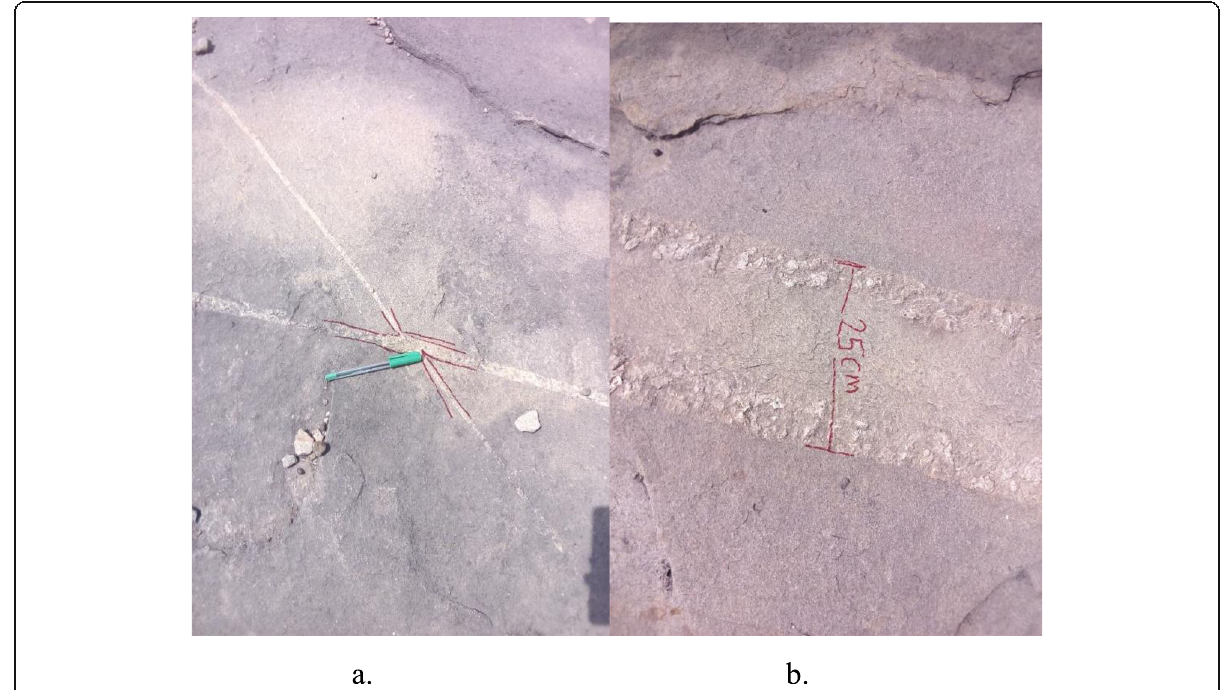
Fig. 11 Photograph of veins on biotite muscovite granite and granitic gneiss. a Biotite muscovite granite. b Granitic gneiss